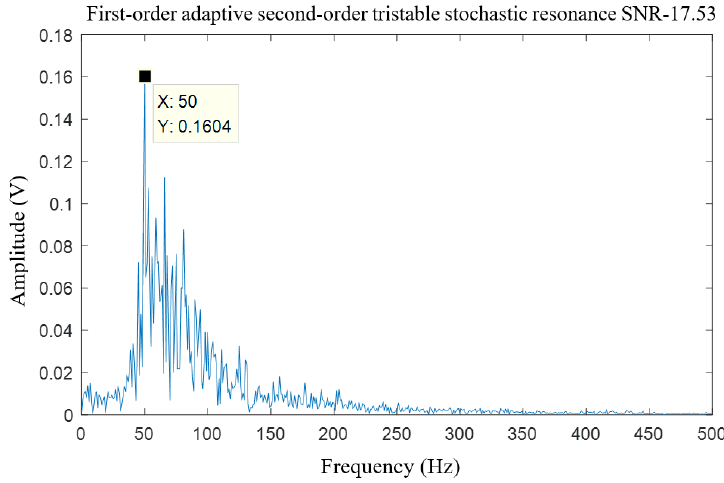
Figure 7. The output spectrum of the first cascade system.